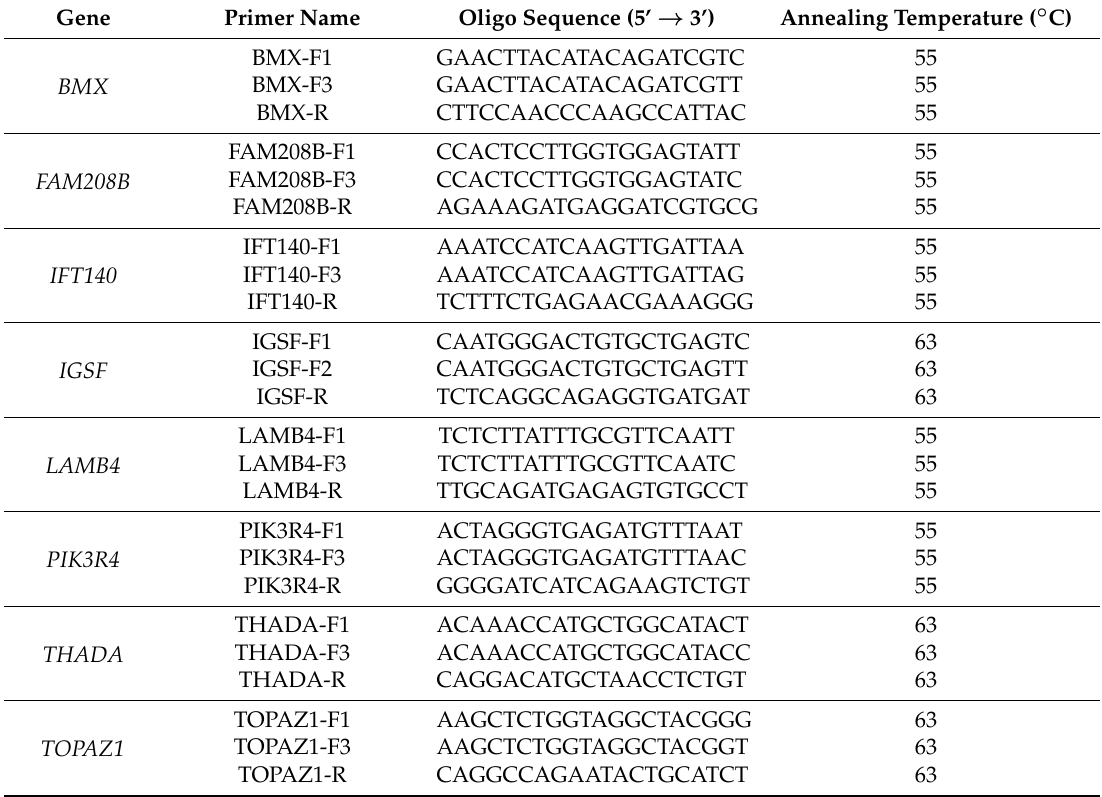
Table 1. Primers used for allele-specific polymerase chain reaction